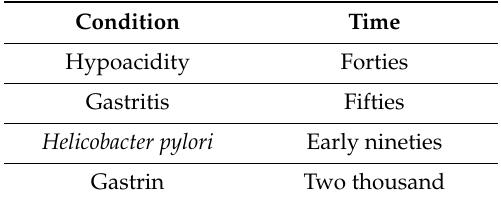
(Gastrin is the common factor for the first three